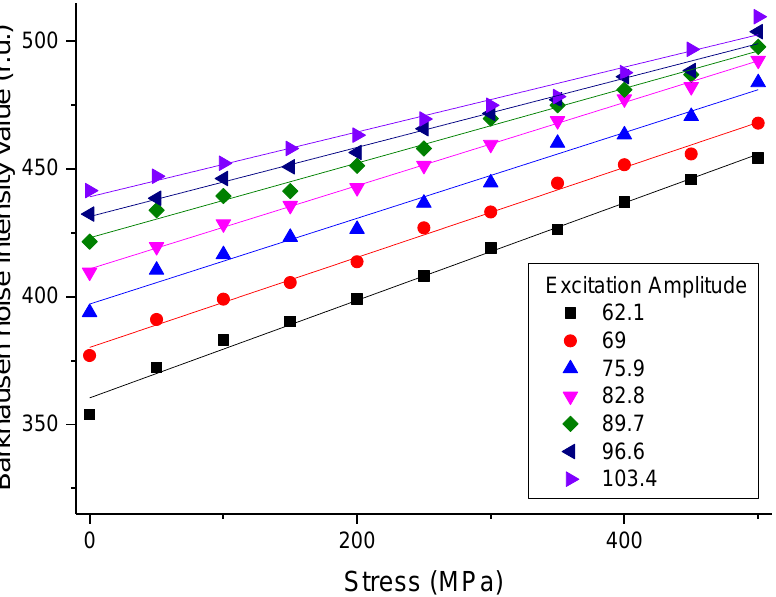
Figure 8. Result of calibration using regression analysis on stress in longitudinal direction vs. magnetic Barkhausen noise intensity value graph.